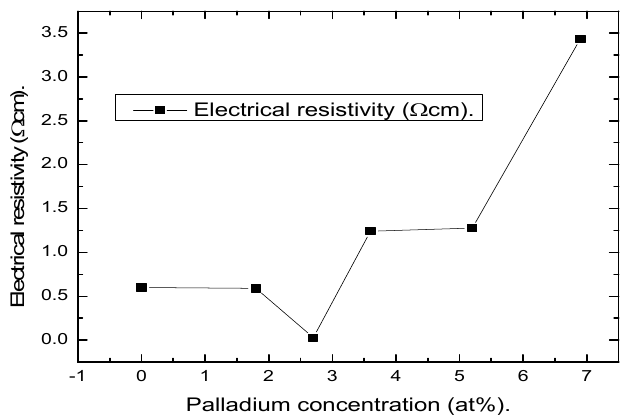
Figure 4. Sheet resistivity characteristics of Pd:SnO 2